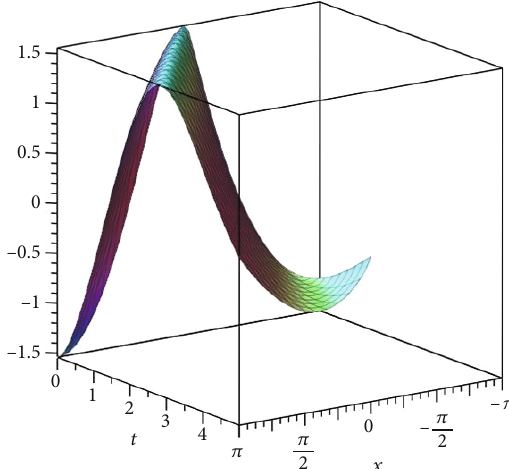
ð x , y , t Þ given by (22) 1